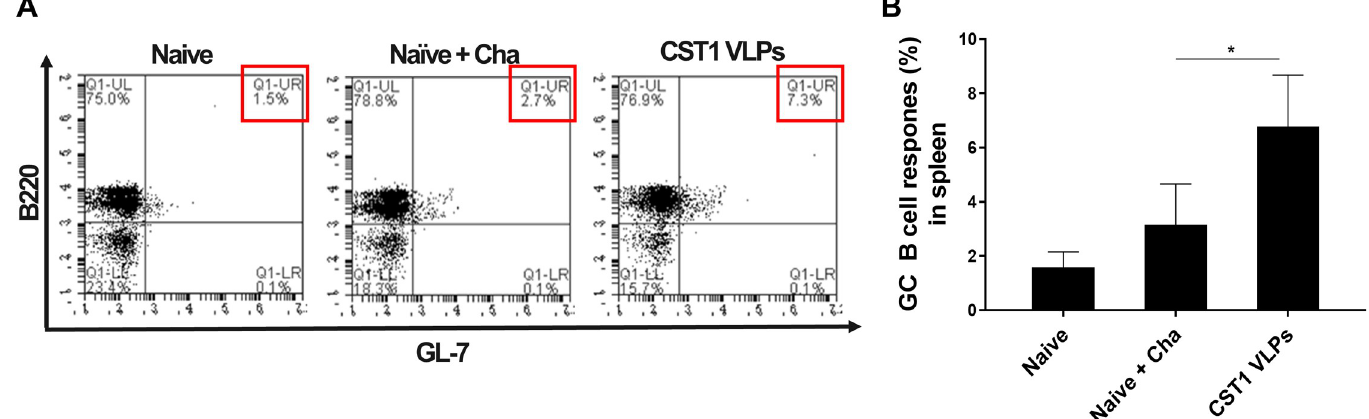
Fig 5. Germinal center B cell responses in spleen. BALB/c mice were intranasally immunized twice with CST1 VLPs at a 4-week interval. Four weeks after the final immunization, mice were orally challenge-infected with T . gondii ME49. Spleens were harvested at 40 dpi and single cell splenocyte populations were stimulated with the Tg ME49 Ag. GC B cell populations were determined using flow cytometry. (A) Representative scatter plots showing B220+/GL-7+ GC B cells from each group were illustrated. (B) Mean GC B cell responses from each group were depicted using a bar graph. Data are shown as mean ± SD, and an asterisk was used to denote statistical significance between the groups ( * P < 0.05). Splenocytes were collected on an individual basis and representative flow cytometry data acquired from 2 independent vaccination and challenge infection studies were used.